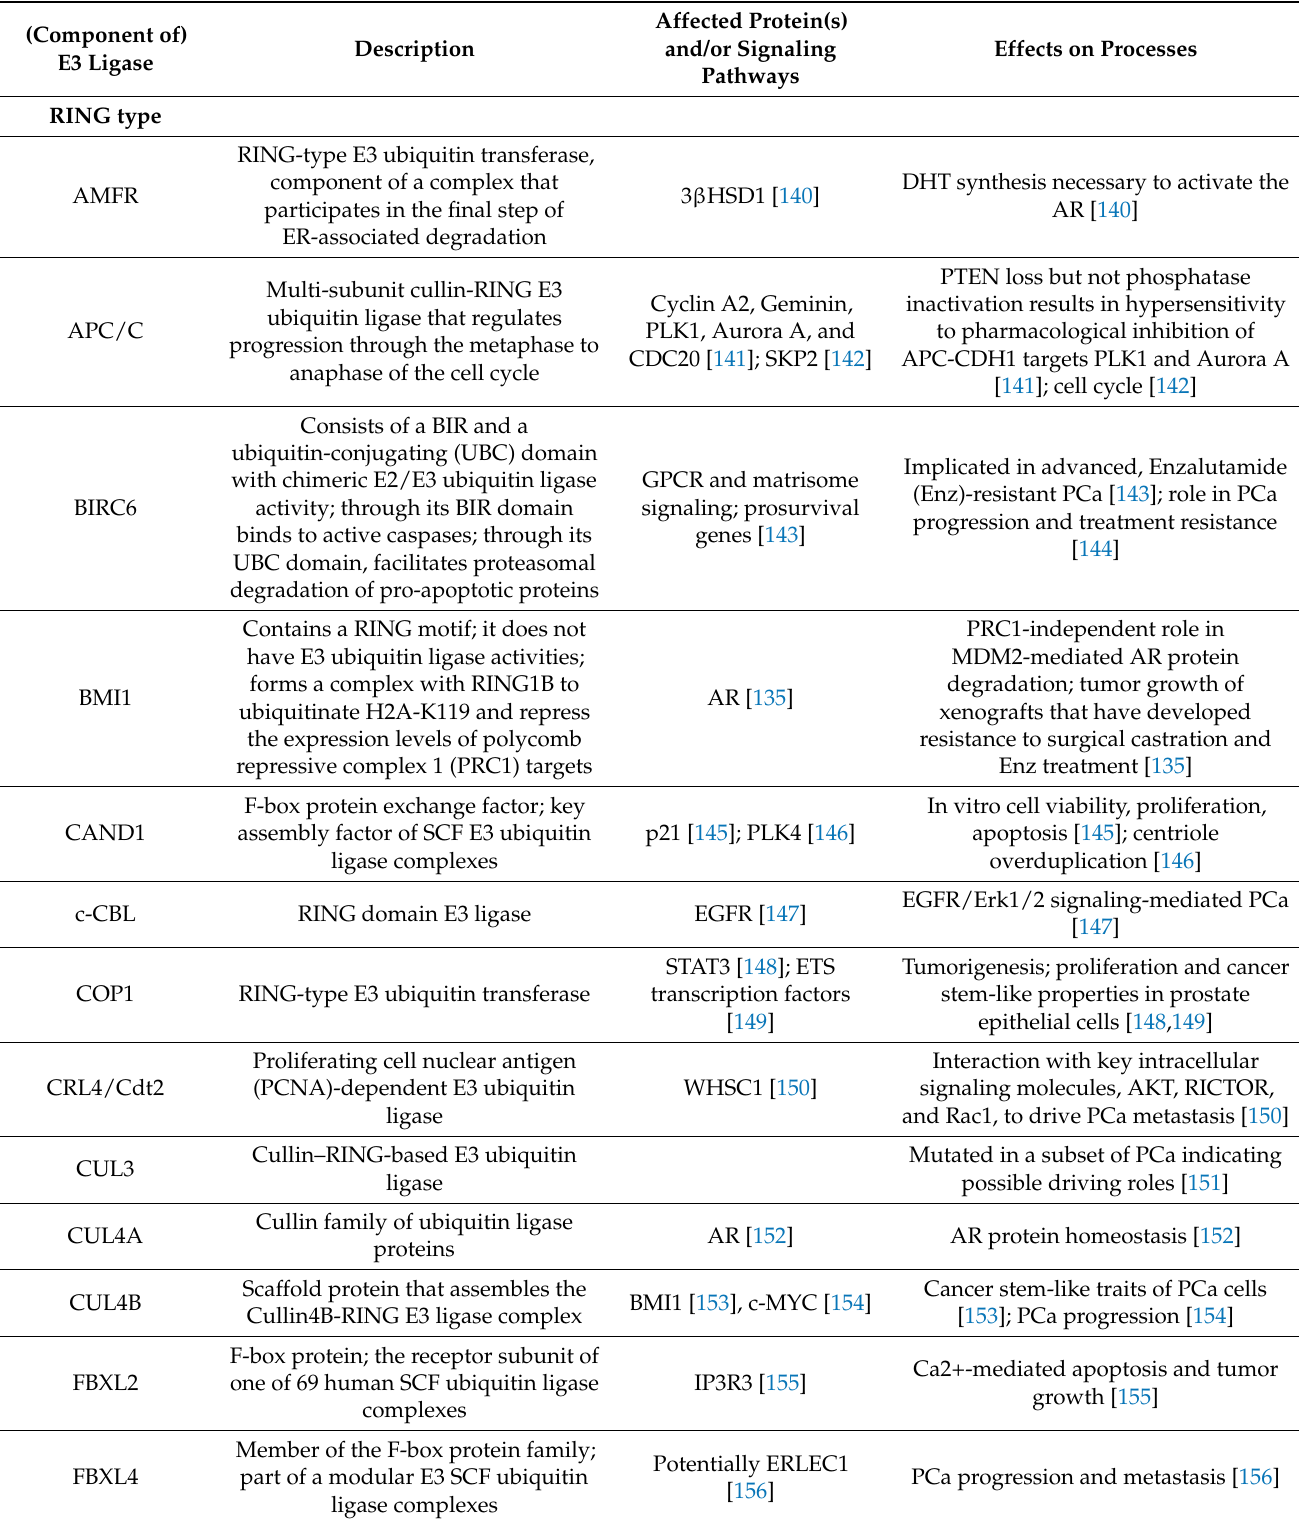
Table 3. Ubiquitin E3 ligases, their target proteins, and processes they influence in prostate cancer. Signaling pathways regulated by deubiquitinases in prostate cancer have been recently reviewed [129], as well as the roles of the SPOP protein [130,131], substrate adaptor of a CRL3 that is frequently mutated in prostate cancer. (Component